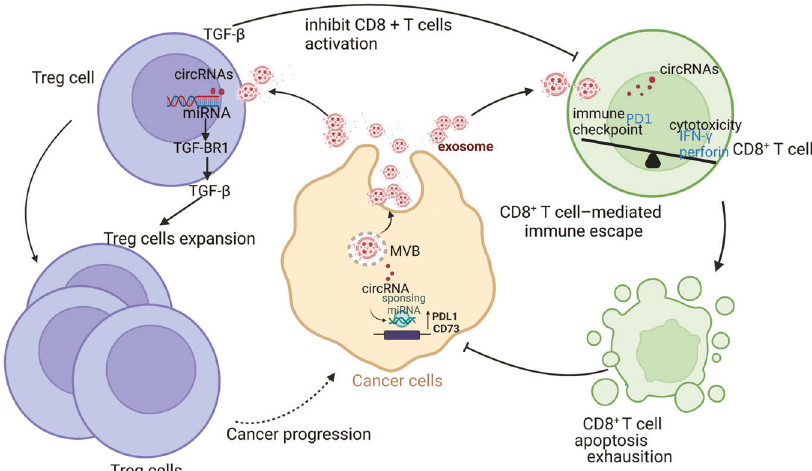
Fig. 2 Circular RNAs modulate T-cell function. TGF- β transforming growth factor- β . TGF- β R I transforming growth factor beta receptor I. IFN- γ interferon γ . Treg regulatory T cells. PD1 programmed cell death. PDL1 programmed cell death ligand